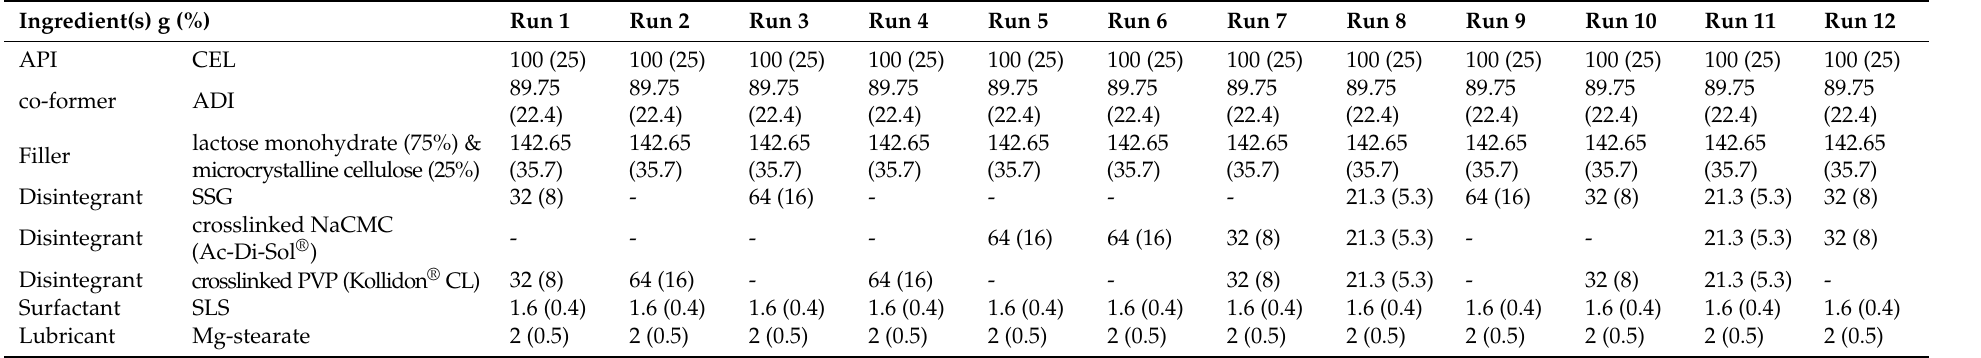
Table 4. List of components for CEL immediate release (IR) tablet formulations for DoE mixture design runs. SSG (X1), cross-linked CMC (X2) and cross-linked PVP (X3); independent variables: disintegrant (SSG + PVP + CMC) = 64 mg (16%),